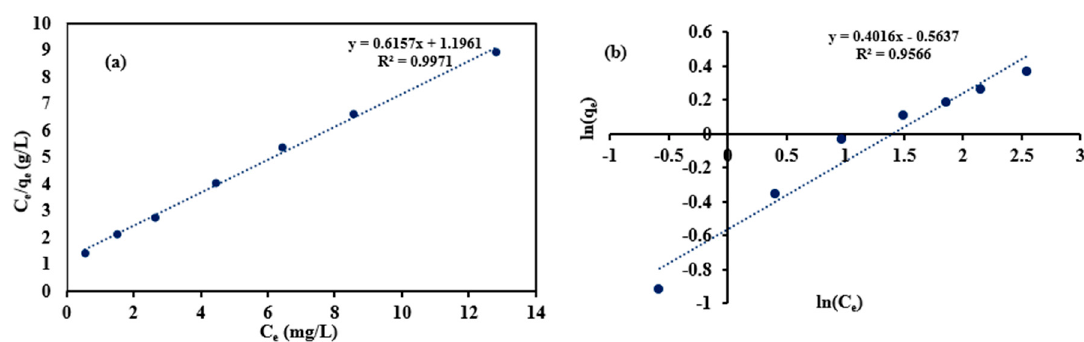
Figure 11. The linear adsorption isotherms of the trimethoprim antibiotic onto Bio-MOF: ( a ) Langmuir model and ( b ) Freundlich model.